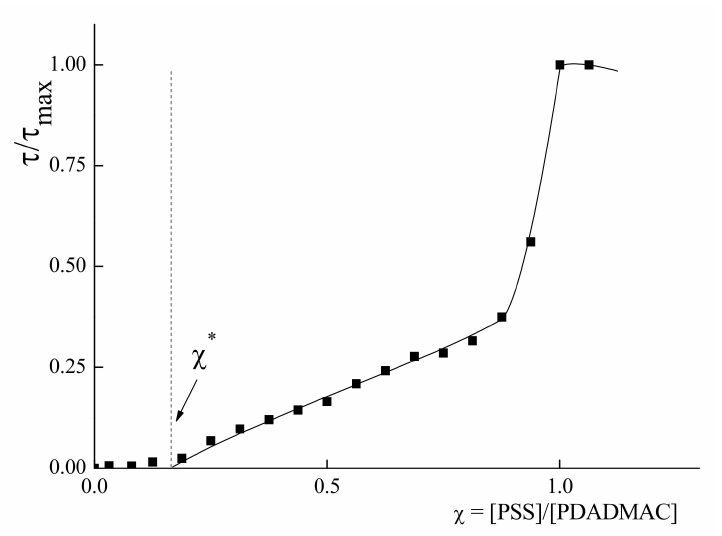
Figure 1. Turbidimetric titration curve for the PDADMAC mixture with PSS. C NaCl = 0.005 M, C PDADMAC = 4 × 10 − 4 base-mol/L, pH 7.0.